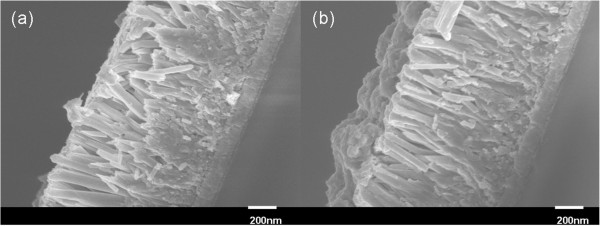
Cross-sectional SEM images of PbS-TiO2nanostructures without (a) and with (b) CdS capping layer.